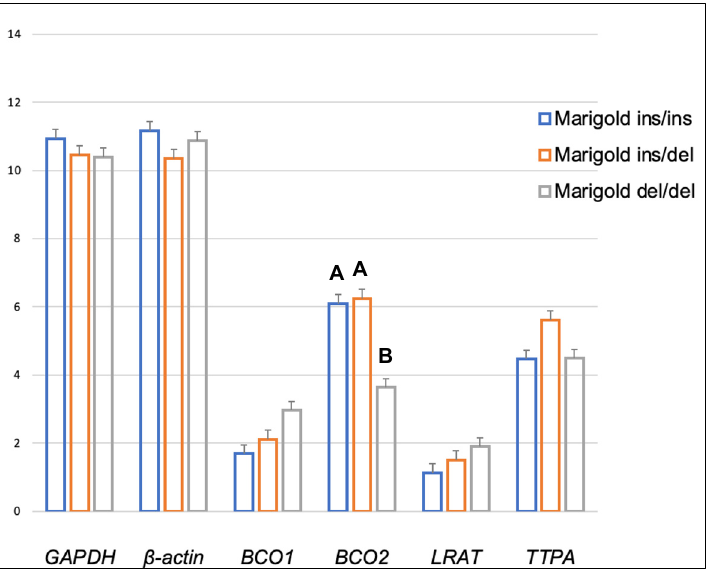
Figure 2. Relative BCO1 , BCO2 , LRAT, and TTPA mRNA levels (log2 abundance) in the perirenal fat of rabbits with different genotypes at codon 248 of the BCO2 gene (ins/ins vs. ins/del vs. del/del) fed a diet with the addition of Aztec marigold flower extract. GAPDH and ß ‐ actin were used as reference genes. Data represent posterior means (expressed as arbitrary units) ± SEM (standard error of the mean). Means within a row followed by the different superscripts (A, B) differ highly significantly ( p ≤